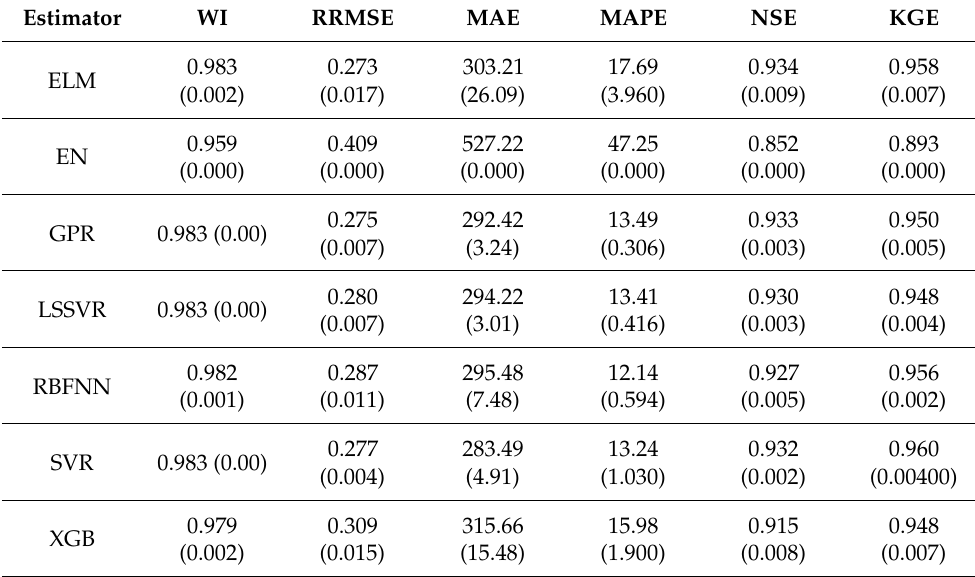
Table 12. Model results for Case 6.